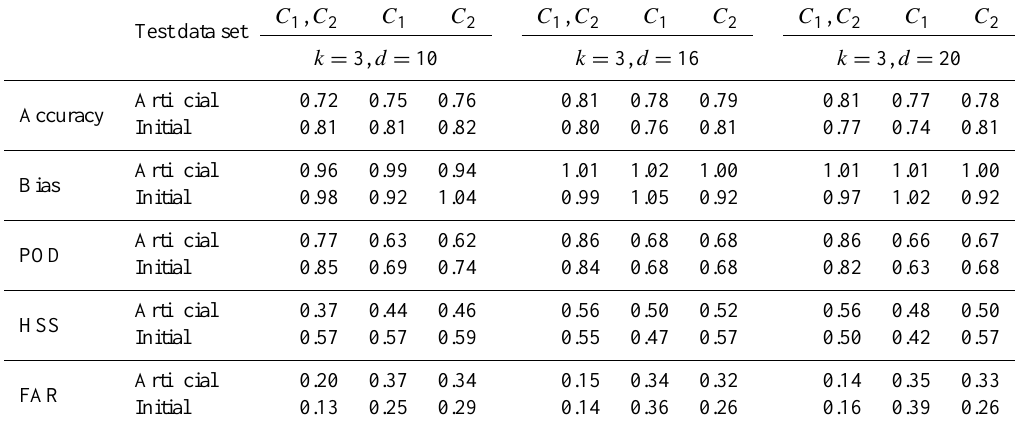
Table 2. Statistical scores related to the RainCEIV rain rate results obtained classifying the initial and artificial test data set for k = 3. The statistical scores are shown for all the rainy classes ( C 1 , C 2 ) , light to moderate rain ( C 1 ) , and heavy to very heavy rain ( C 2 ) .